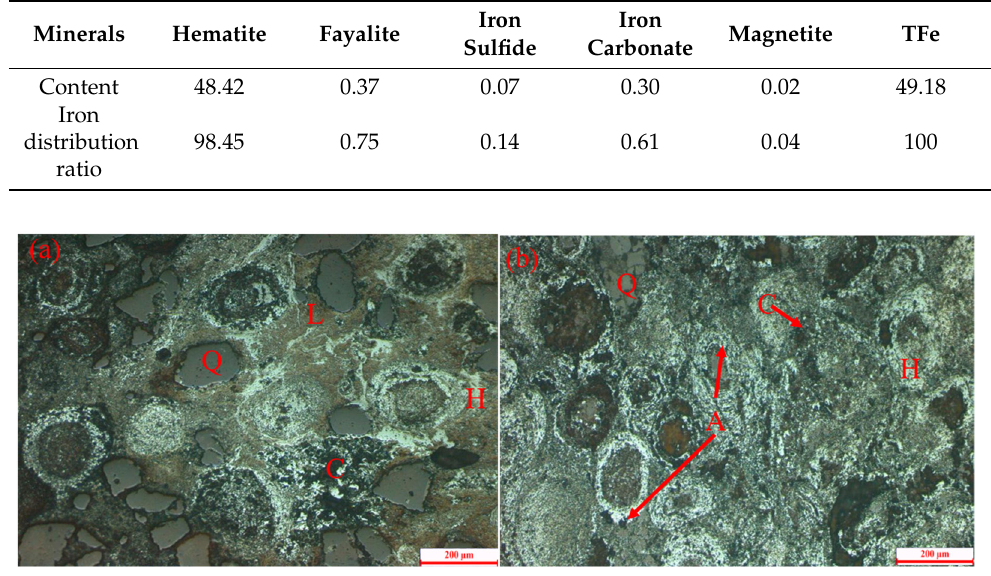
Figure 2. Microstructure of HPOHO (L: Goethite, H: Hematite, Q: Quartz, C: Chamosite, A: Apatite). ( a ) and ( b ) are the microstructure of HPOHO observed under a microscope